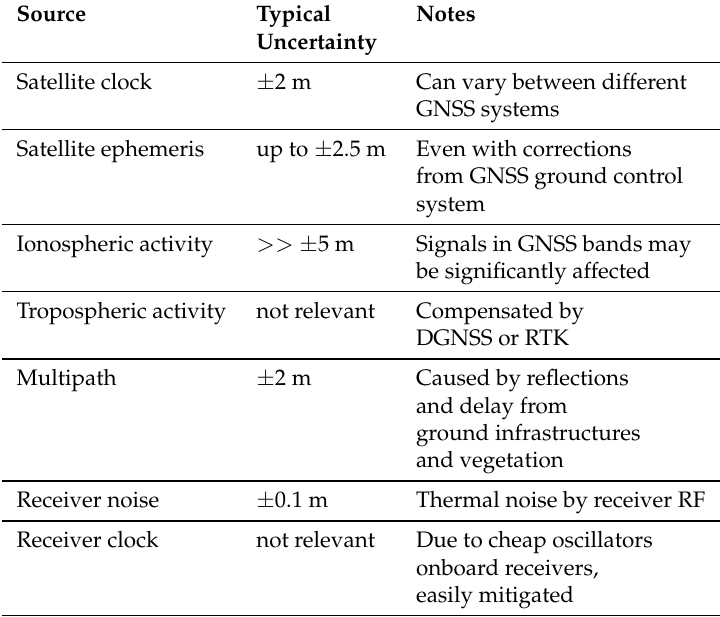
Table 2. Sources of uncertainty in GNSS pseudoranges measured by a